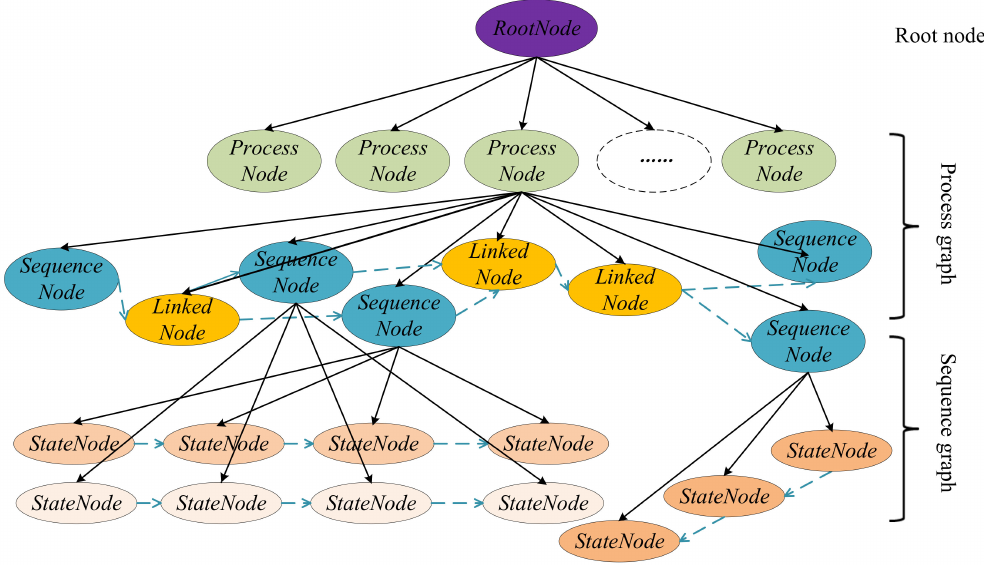
Figure 5. A process-oriented two-tier graph model: The solid line represents the including relationships, and the dot line represents the evolution